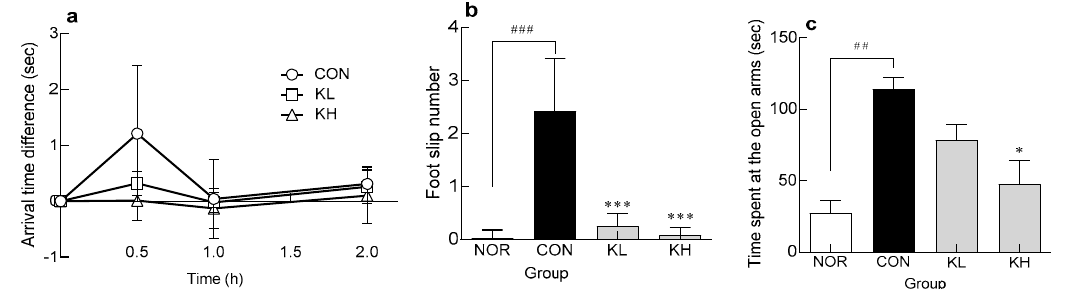
Figure 7. Effect of GBK on ethanol-induced behavioral changes in mice. ( a , b ) The balance beam test and ( c ) elevated plus maze test. Values are mean ± SEM. GBK was administered orally 30 min before ethanol administration. ## p < 0.01 and ### p < 0.001 vs. NOR group; * p < 0.05 and *** p < 0.001 vs. CON group (ANOVA followed by Tukey’s test). CON, control group; KL, low-dose GBK group (15 mg/kg); KH, high-dose GBK group (30 mg/kg).